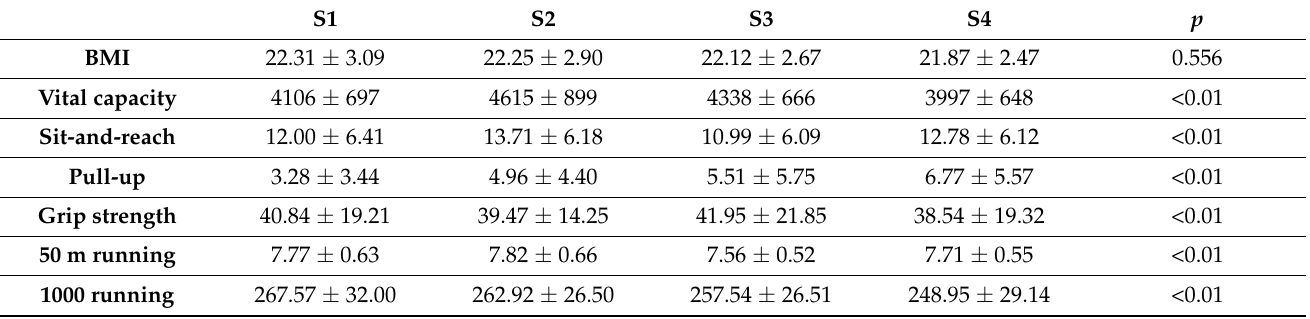
Table 3. The results of Kruskal–Wallis test: the difference in physical fitness of male students.